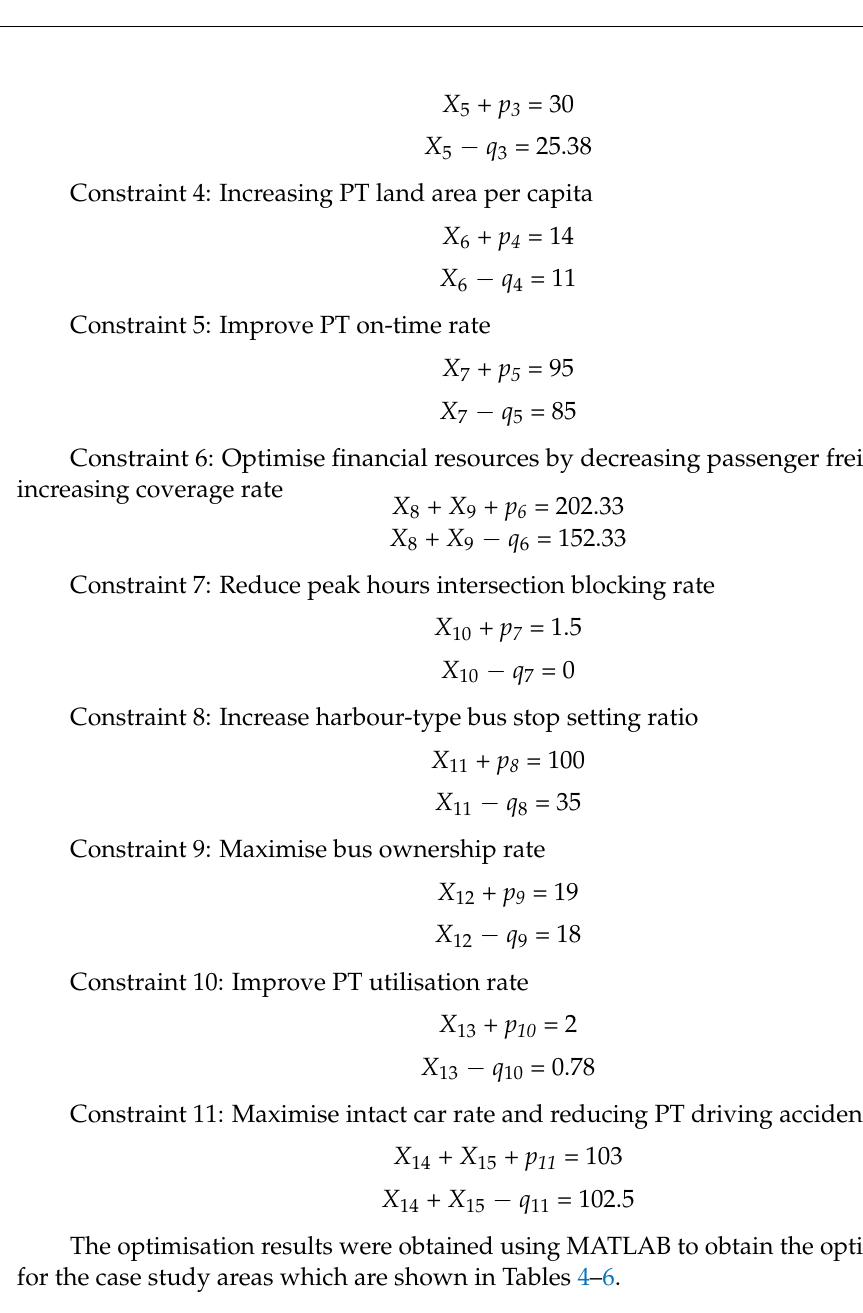
Table 4. Optimal solution for